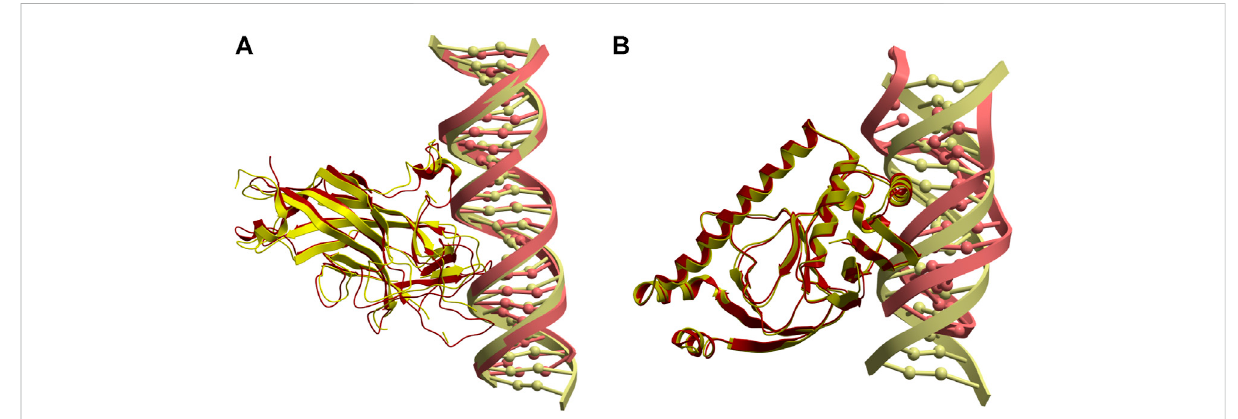
FIGURE 4 Application of pyDockDNA to case studies. (A) Near-native model (in yellow) obtained by pyDockDNA docking between a modelled 22bp DNA (receptor) and Ebf1 (ligand). This model was ranked 5 with pyDockDNA (no desolvation) scoring function and has L-RMSD 3.33 Å with respect to the reference (PDB 3MLO; in red). (B) Reasonable model (in yellow) obtained by pyDockDNA docking between the catabolite gene activator protein (receptor)andamodelled11bpDNA(ligand).Thismodelwasranked5withpyDockDNA(eitherwithdesolvationorwithnodesolvation)scoring function and has L-RMSD 10.76 Å with respect to the reference (PDB 1O3R; in